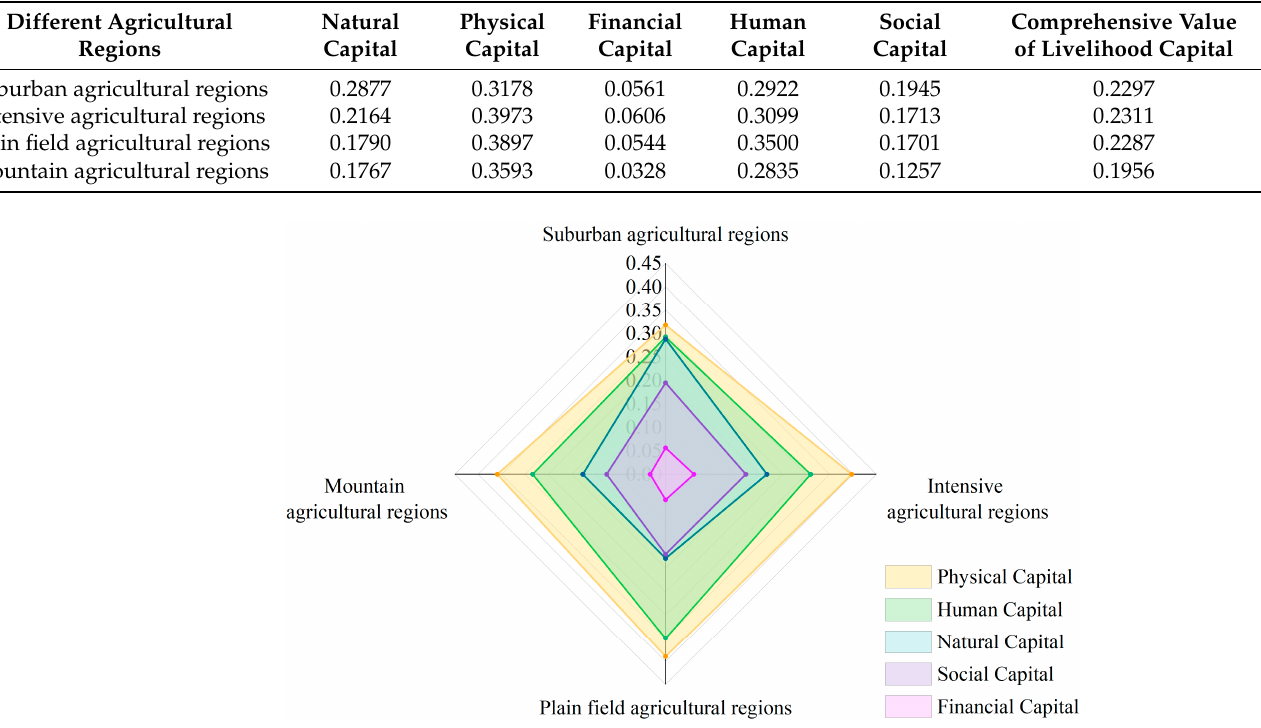
Table 4. Comparison of livelihood capital per rural household in different agricultural regions.